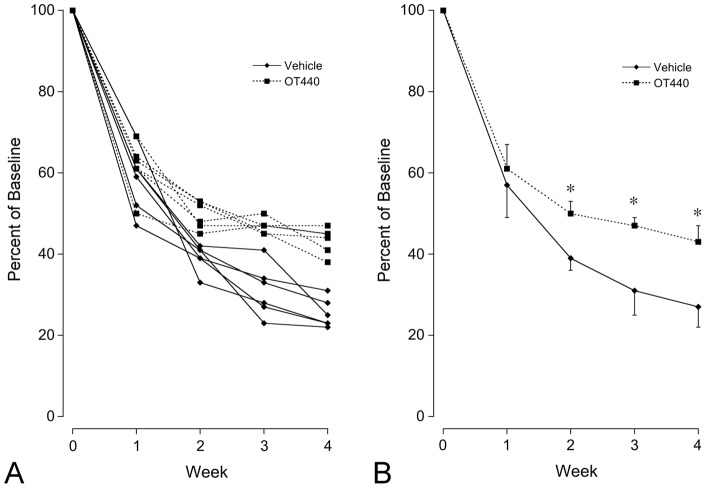
Loss of fluorescent neurons during the four weeks in defined retinal areas following optic nerve crush in mice that received cream cheese vehicle or OT-440 in cream cheese.Total data graph (A) shows that the general pattern for each eye was a more rapid decline during the first week of the study followed by slower decline in the subsequent weeks. Mean data graph (B) shows significant differences between the vehicle and OT440 groups at weeks 2, 3 and 4. N = 7 for each data point in the vehicle group except for weeks 2 and 3 where N = 6 due to a corneal scratch in one animal that later healed. Similarly, N = 6 for each data point in the OT-440 group except for week 3 where N = 5. Asterisks indicate P<0.001 (students t-test). Error bars indicate SD.